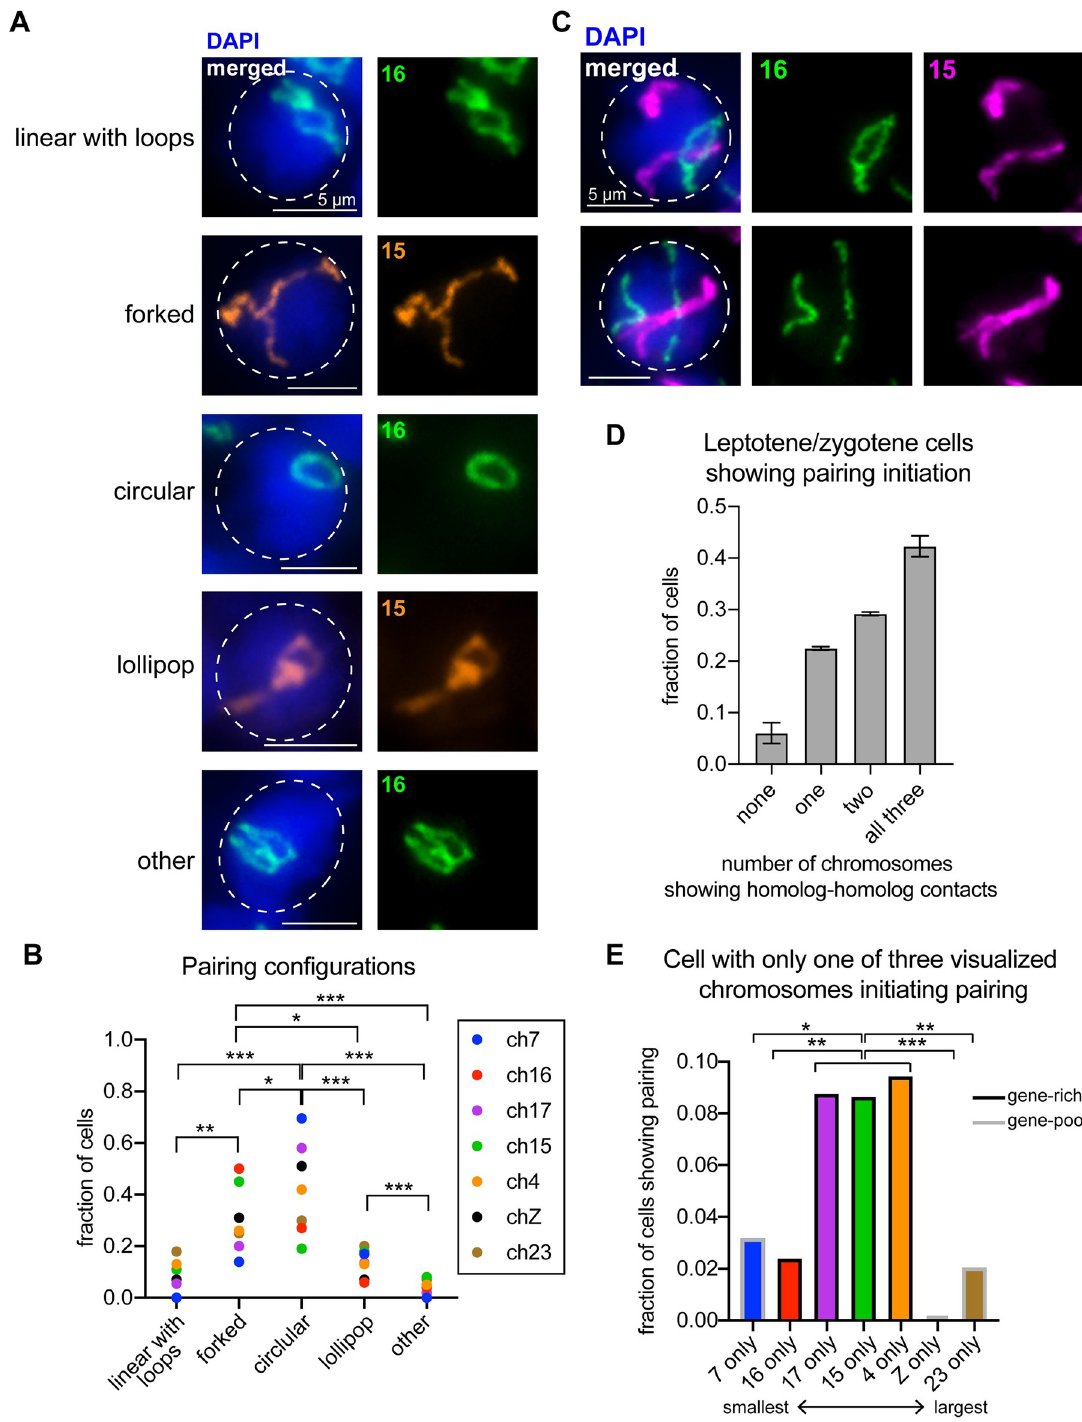
Fig 4. Whole chromosome Oligopaints in zygotene-pachytene transition show a variety of folding and pairing configurations. (A) Oligopaints for ch16 (green) or ch15 (orange) in representative zygotene nuclei showing the most prevalent partially paired chromosome configurations during pairing initiation. Dashed line approximates the nuclear edge. (B) Frequency histogram showing the fraction of cells harboring chromosomes in each partially paired configuration for the indicated chromosome. Statistics, Mann-Whitney test with each chromosome as a replicate. (C) Oligopaints for ch16 (green) and ch15 (magenta) in representative zygotene nuclei showing asynchronous pairing initiation. Top: Ch16 has begun pairing while ch15 remains entirely unpaired. Bottom: Ch15 is